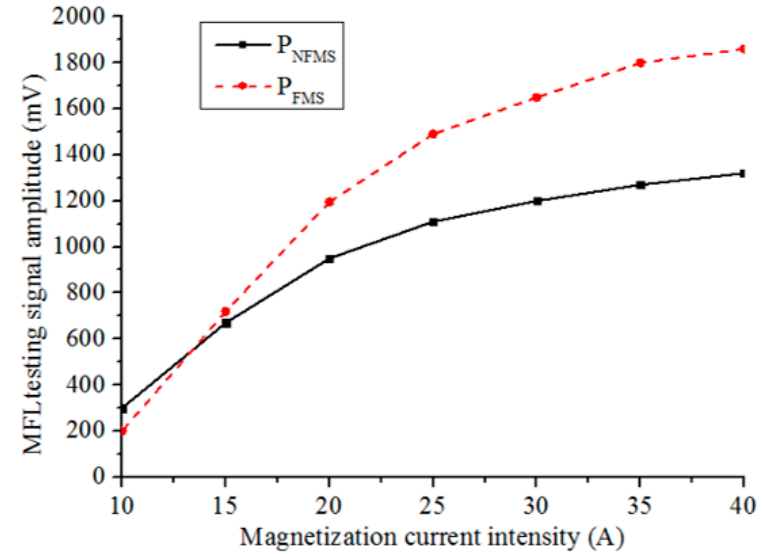
Figure 12. The testing signals captured by PNFMS and PFMS.